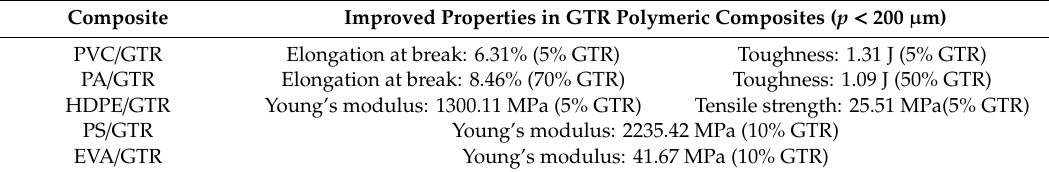
Table 3. Optimum values of analyzed features and GTR composite ( p < 200 µ